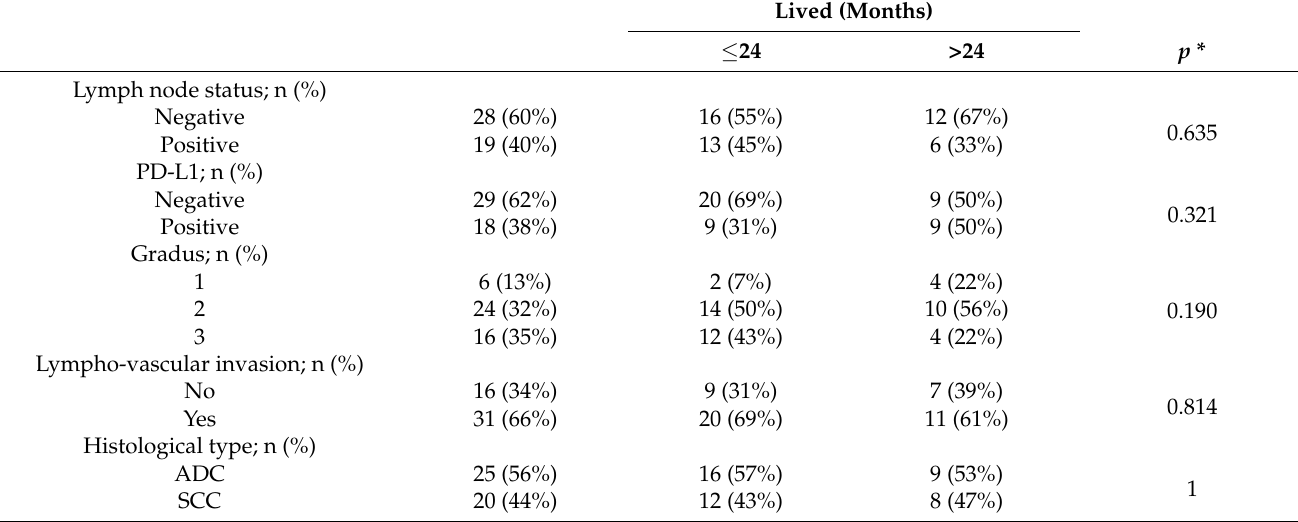
Table 6. Dead patients (n = 47) according to analysed variables and OS ( ≤ 24 months; >24